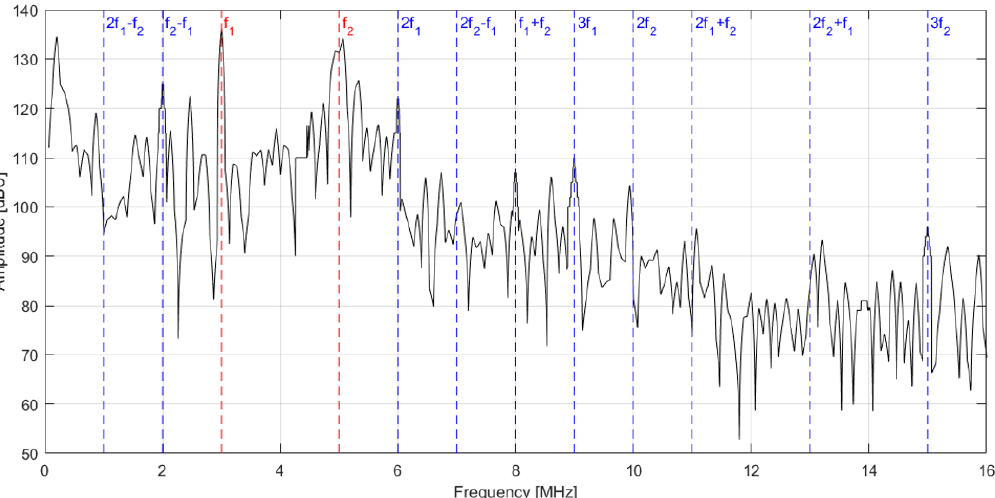
Figure 7. Frequency spectrum, LS-DYNA simulation with excitation frequencies f 1 = 3 MHz and f 2 = 5 MHz.